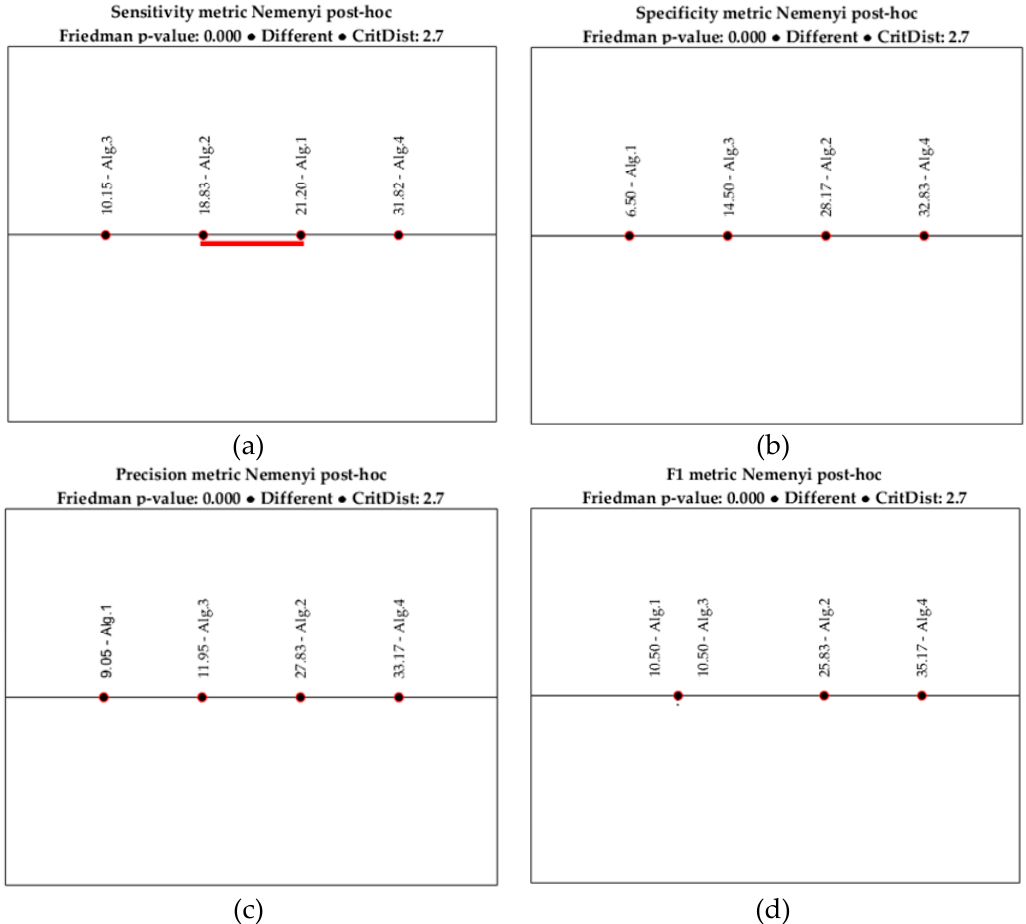
Figure 6. Nemenyi post-hoc tests for the performance metrics: ( a ) sensitivity; ( b ) specificity; ( c ) precision; and ( d ) F1. The red horizontal line in the sensitivity metric test denotes that the Alg. 1 and Alg. 4 are not different.